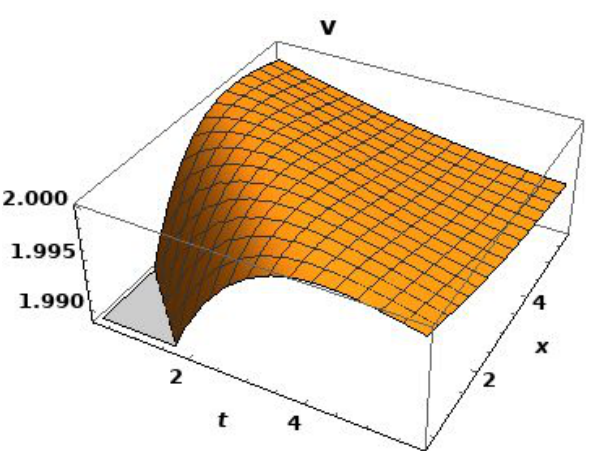
Fig. 4 3D-plot for | v ( x , y , t ) | 2 when y = 0 where a = 1 . 5 and all other parameter values are 1 (Lucas combined hyperbolic function)